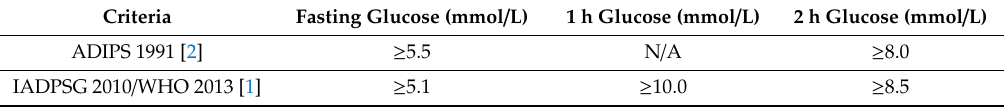
Table 1. Diagnostic criteria for gestational diabetes mellitus (GDM) in Australia. (ADIPS—Australasian Diabetes in Pregnancy Society; IADPSG—International Association of Diabetes in Pregnancy Study